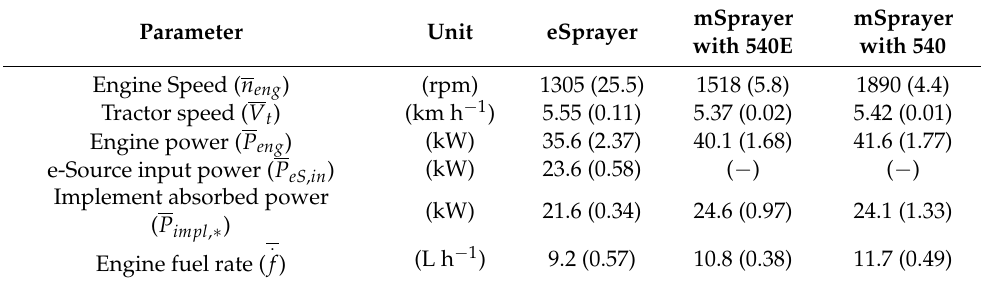
Table 11. Performance parameters obtained with fan speed ( n f ) set at 1800 rpm. In the brackets, the standard deviation of each parameter is